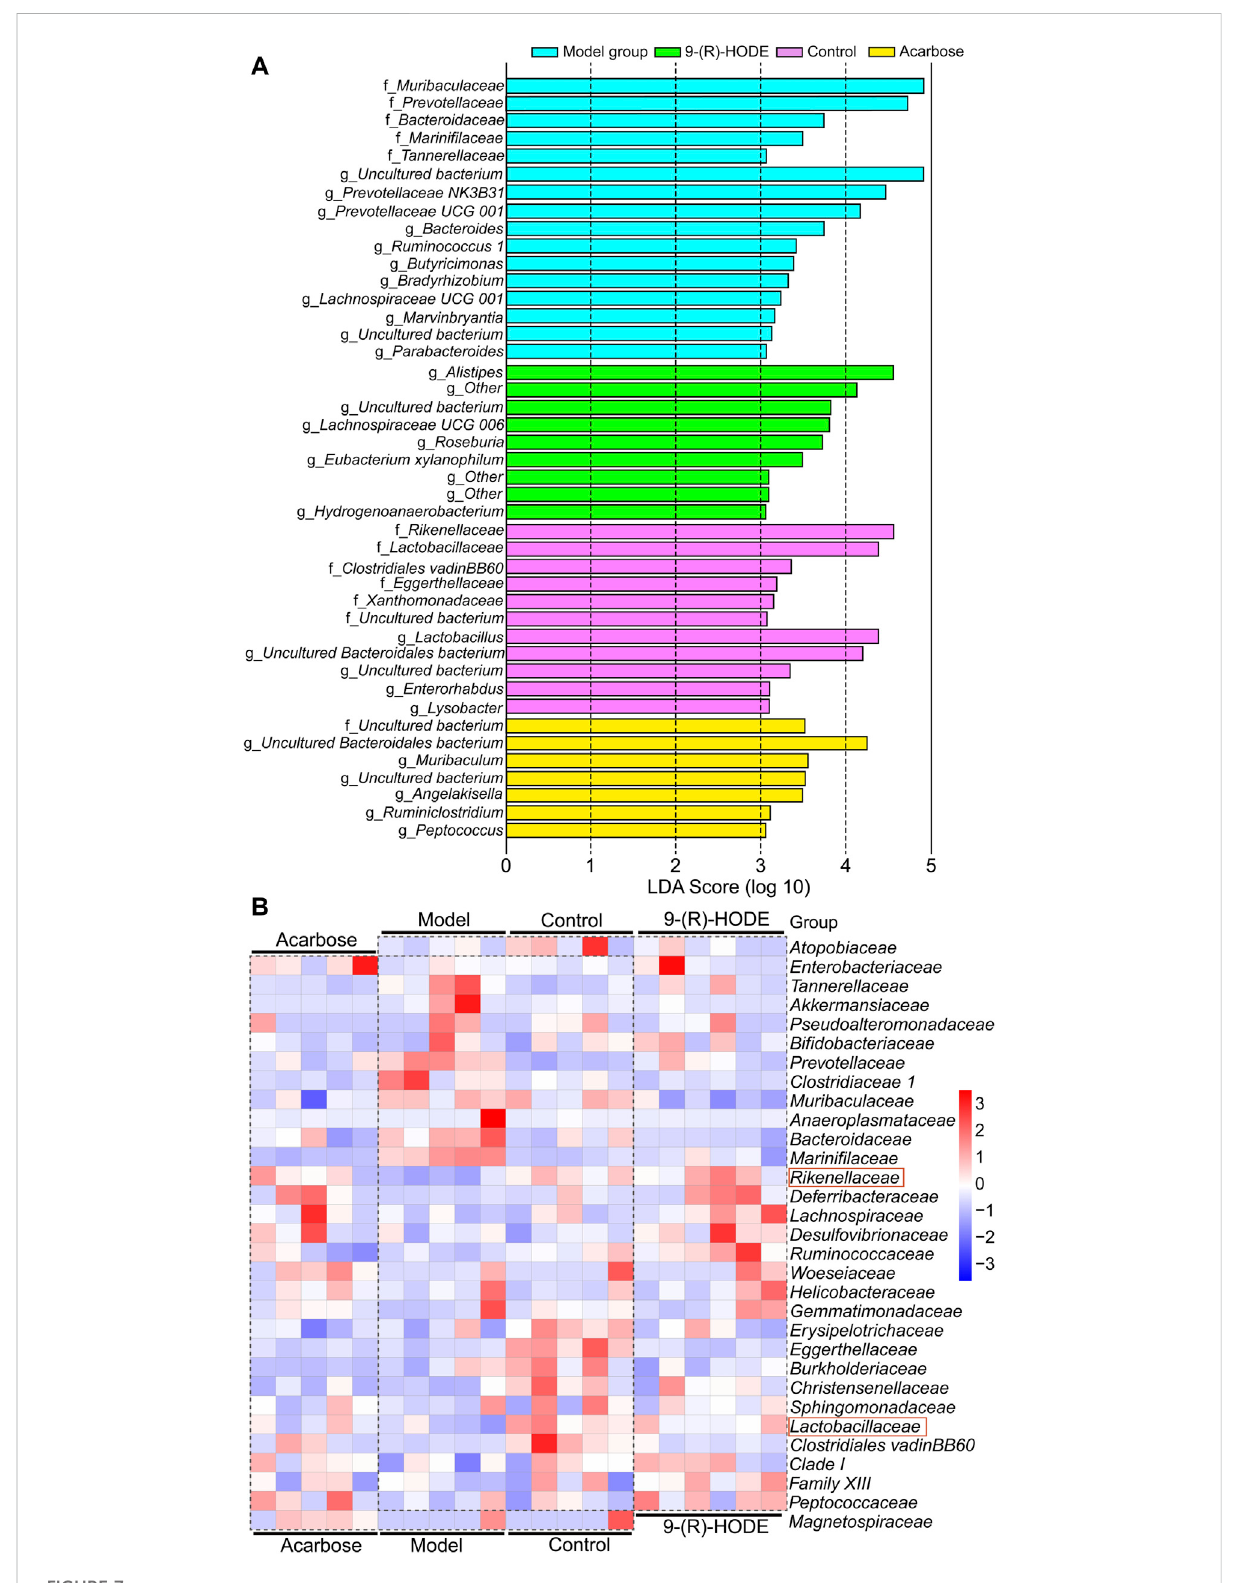
FIGURE 7 Metabolic network of the signi fi cantly altered metabolites involved in 9-(R)-HODE treatment or acarbose. T: 9-(R)-HODE treatment, P: acarbose treatment, C: control group. Green indicates metabolites that were signi fi cantly downregulated, red indicates signi fi cantly upregulated metabolites, while white indicates no signi fi cant changes in metabolites compared with the model